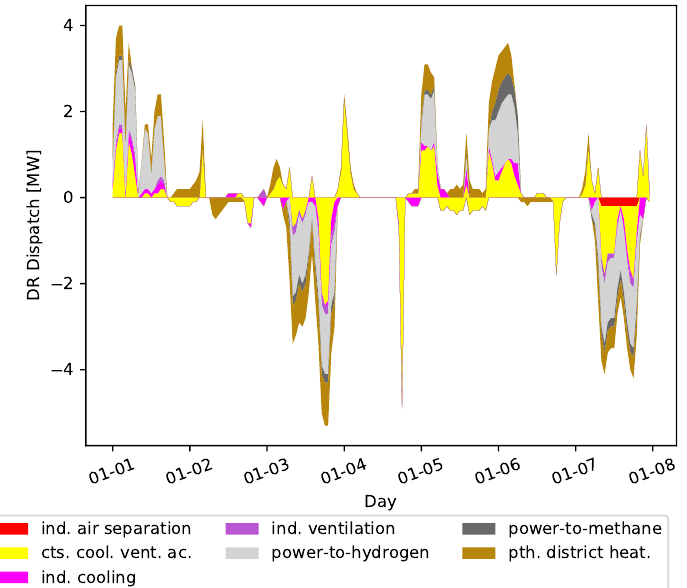
Figure 11. Dispatch of DR technologies at a grid node close to the city of Dortmund in the first week of the year for the case that considered investment costs.